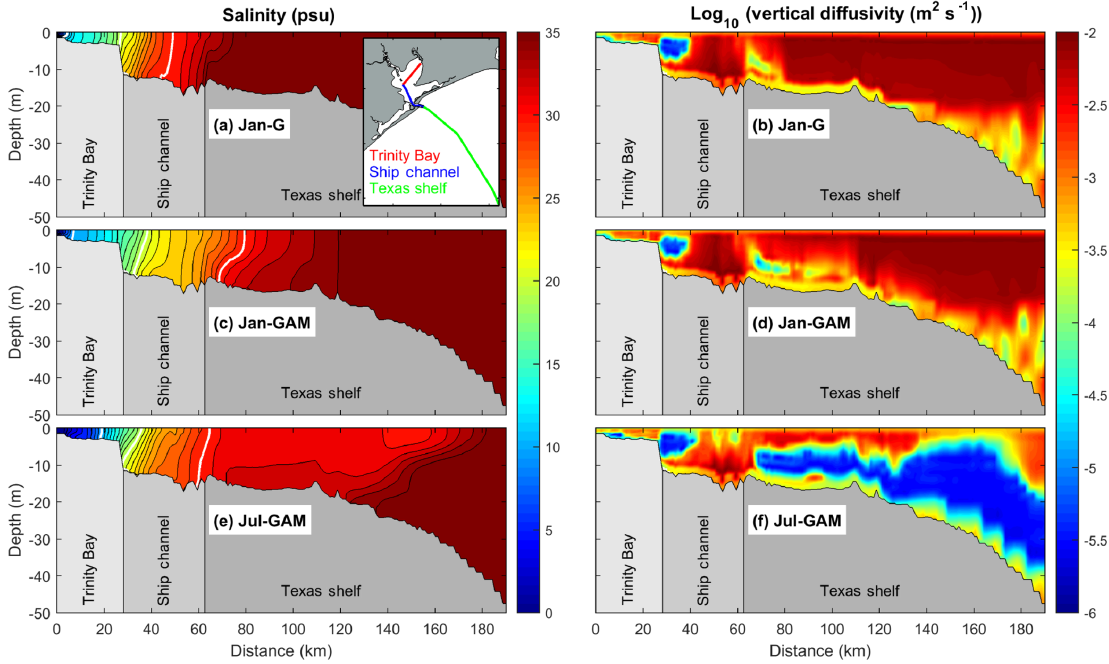
Figure 14. Salinity (a, c, e) and vertical diffusivity (b, d, f) averaged over days 250–300 from three numerical experiments for the section through Trinity Bay, the Galveston Bay ship channel, and the Texas shelf: see the inset in (a) for the section location. In (a) , the bold white lines denote salinity contours of 10, 20, and 30psu.